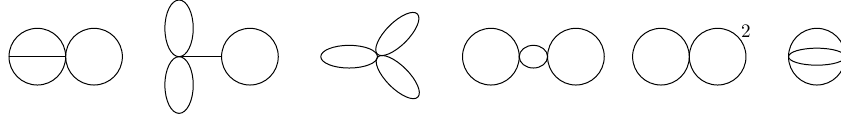
Figure 3 . Diagrams in order of appearance starting at (3.11).